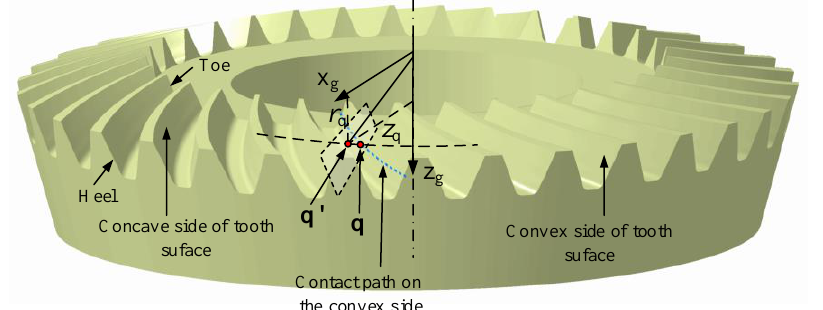
Figure 1. Tooth surface and contact